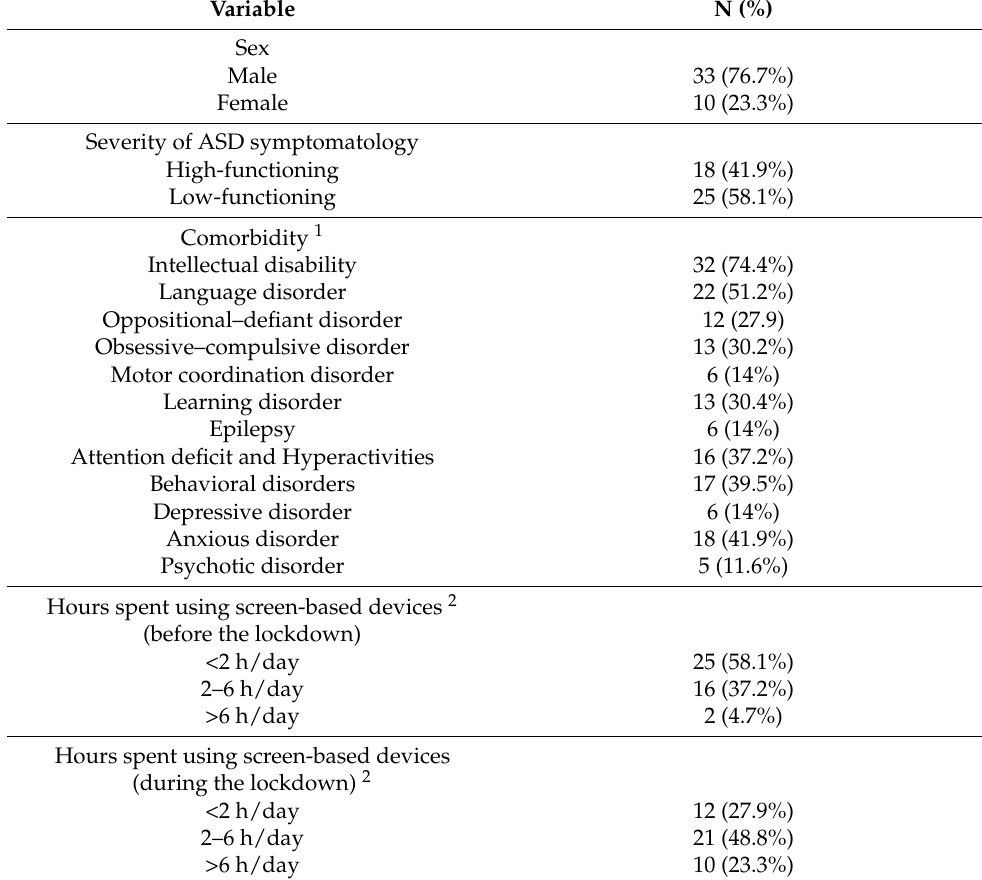
Table 1. Characteristics of adults with ASD.